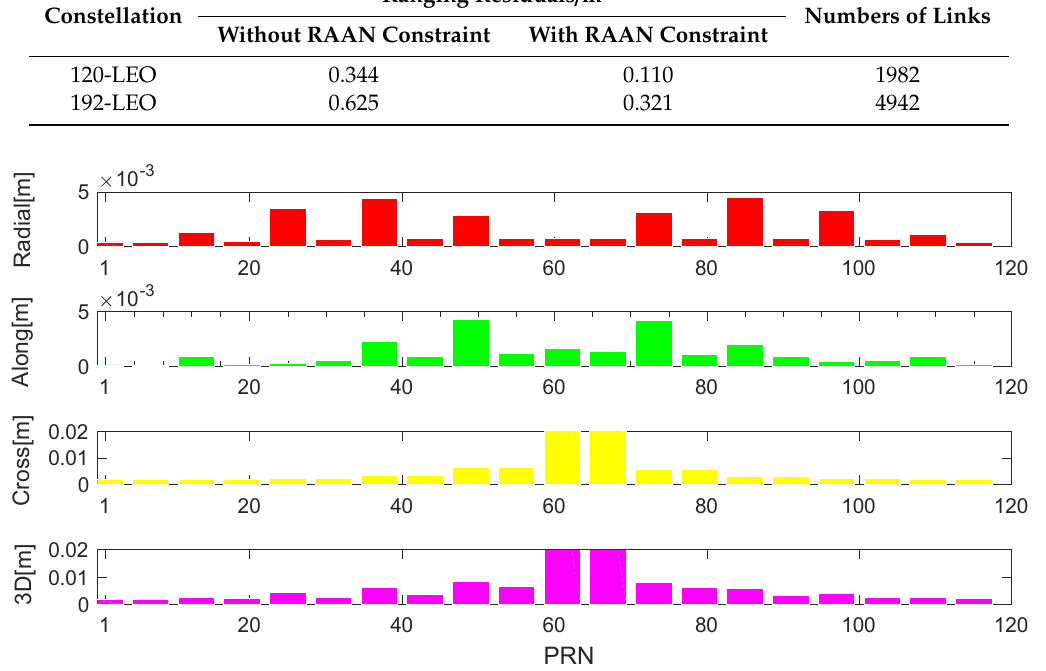
Figure 11. 120-LEO constellation orbital errors in radial, along-track, cross-track, and 3D under 20 cm ranging accuracy, in which satellite of PRN 1, 7, 13, ... , 115 (divided at interval 6 of PRN number) are displayed.